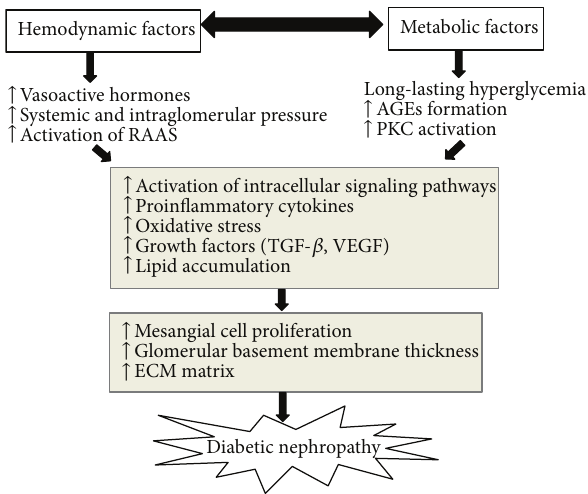
Figure 1: Schematic illustration of the interaction between hemo- dynamic and metabolic factors in the pathophysiology of diabetic